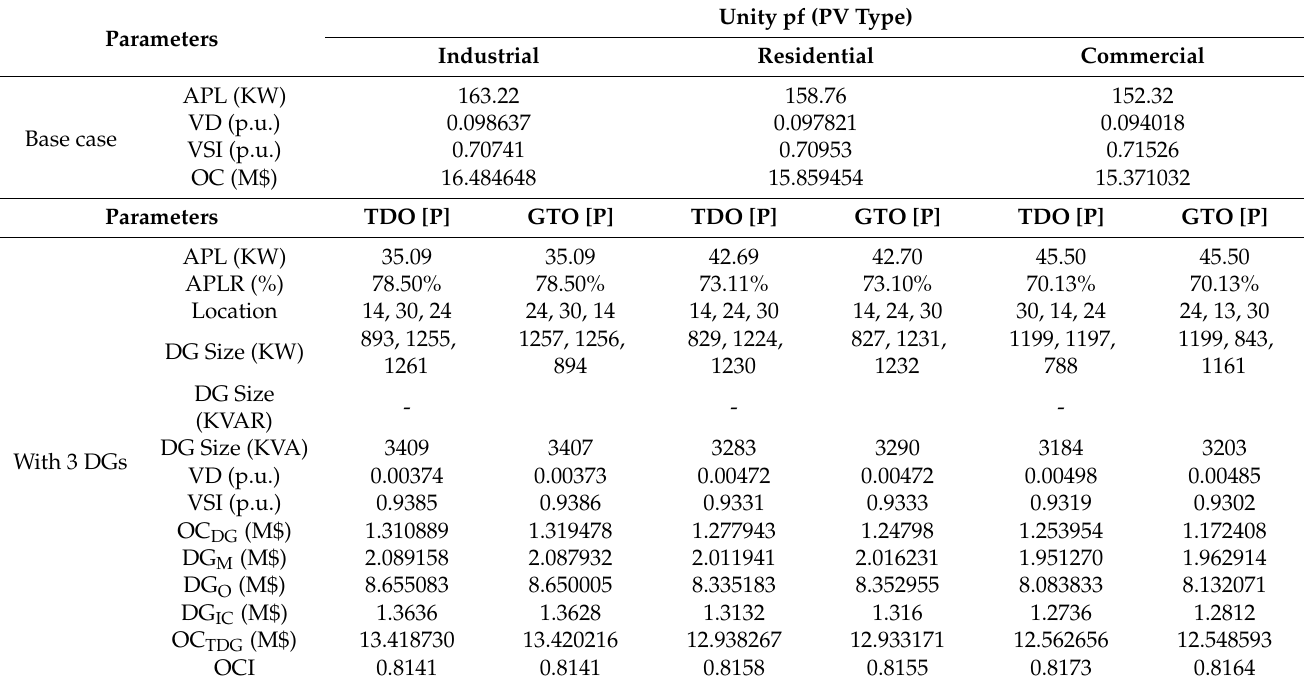
Table 9. Results of the OADG for a 33-bus RDN for MOF at unity pf (PV Type) in a VP load model.